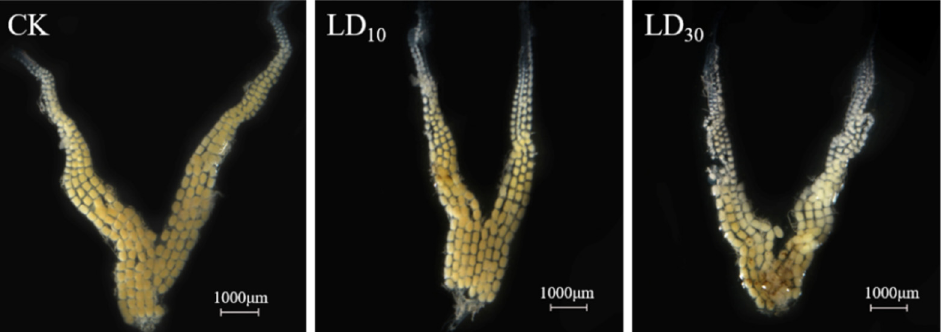
Figure 2. Sublethal effect of fluxametamide on the size of C. suppressalis ovary. Significant differences were shown as different lowercase letters above the bars if p < 0.05 (Tukey’s test).